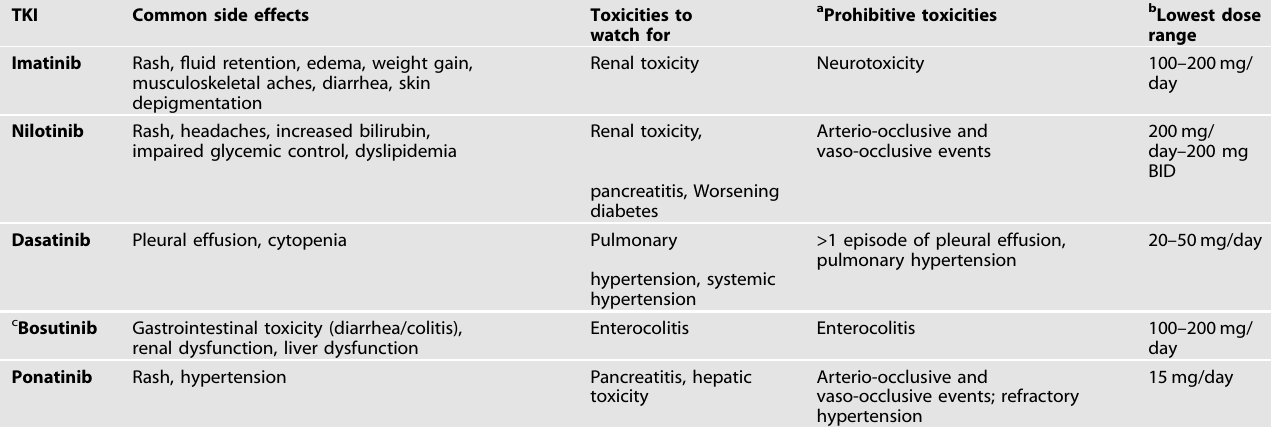
Table 1. Clinically relevant TKI toxicities and reduced dose